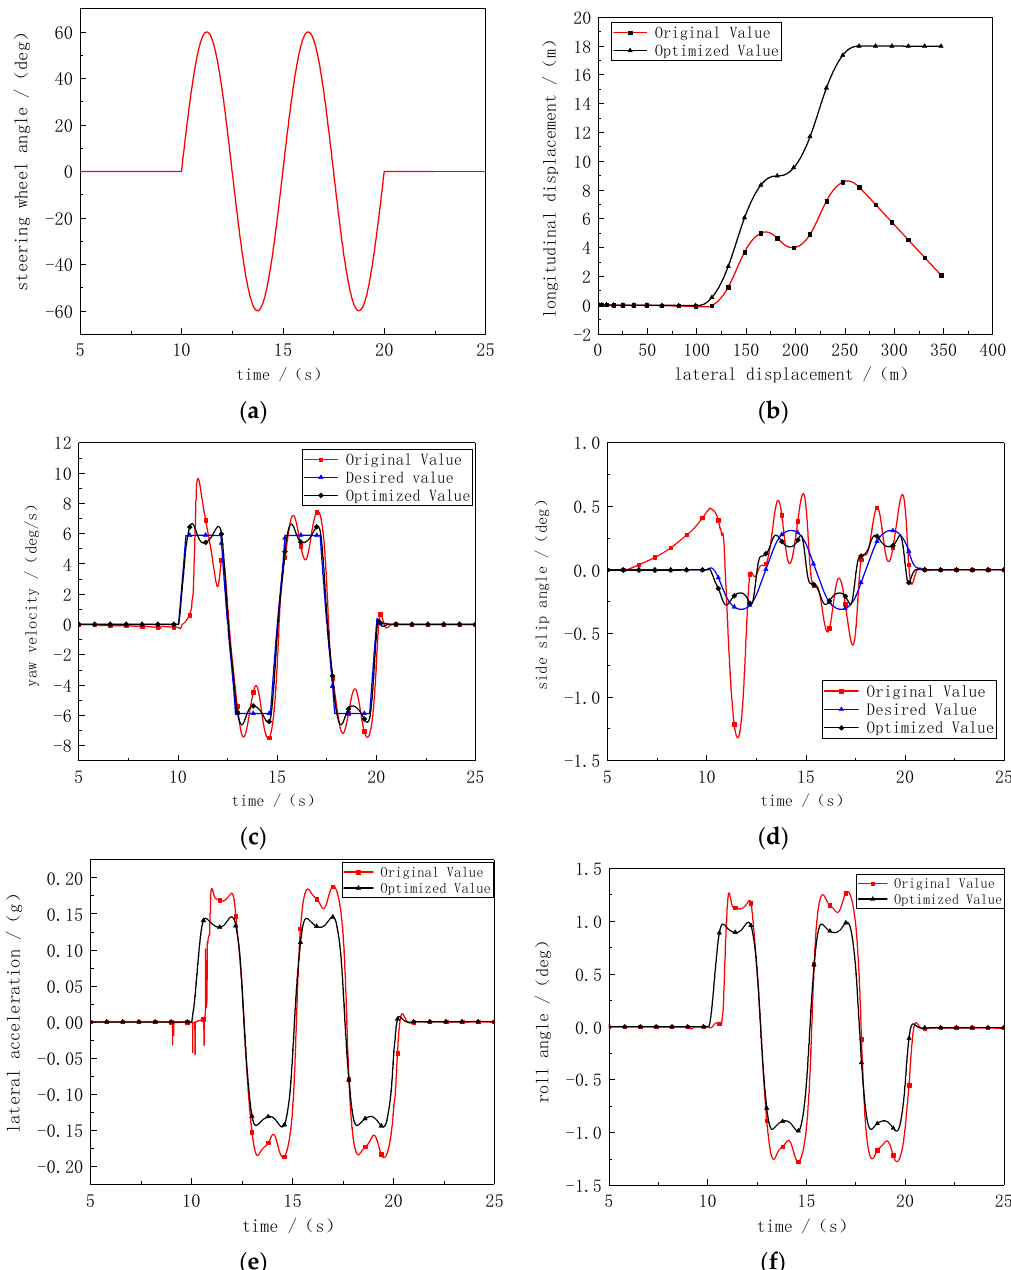
Figure 6. Simulation results of sine input condition. ( a ) Steering wheel angle. ( b ) Vehicle track. ( c ) Yaw velocity. ( d ) Side slip angle. ( e ) Lateral acceleration. ( f ) Roll angle.